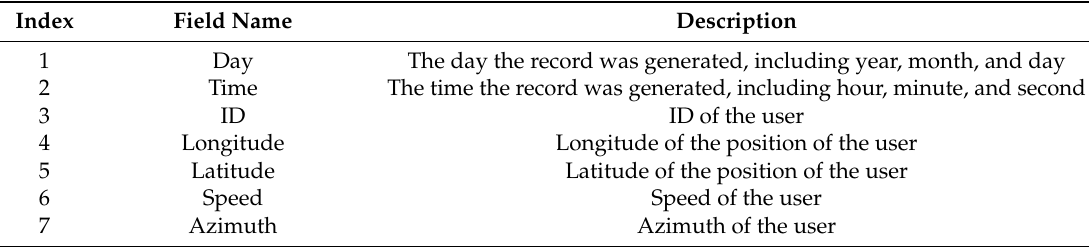
Table 1. Description of the data fields.